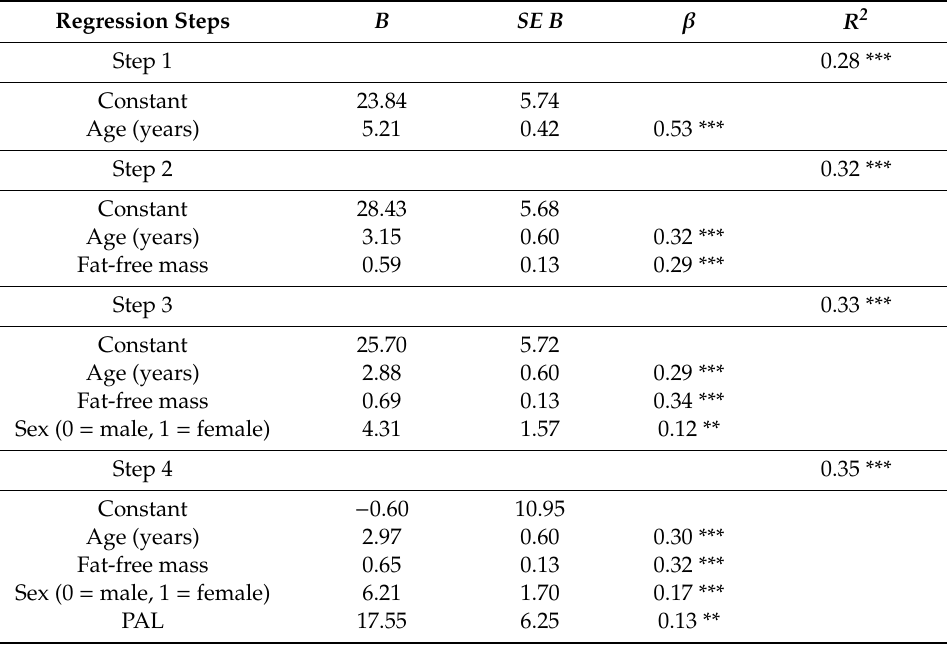
Table 6. Stepwise multiple regression analysis with sti ff ness index (SI) as dependent